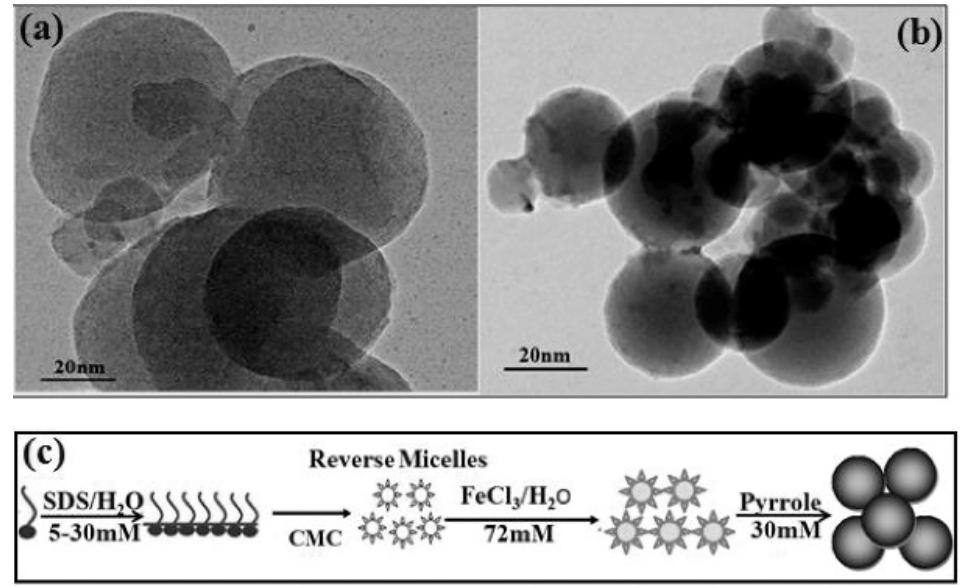
Figure 1. ( a , b ) TEM images of PPy NPs and ( c ) schematic representation of the preparation of PPy NPs [11]. Copyright 2014 Journal of Applied Physics.